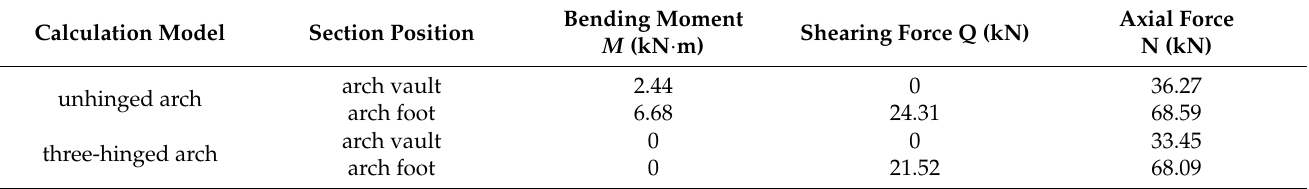
Table 1. Internal forces at the section of the vault and the arch foot under the two calculation